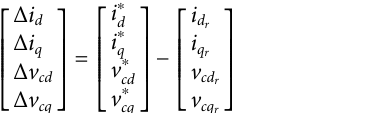
FIGURE 6 | SC voltage regulation